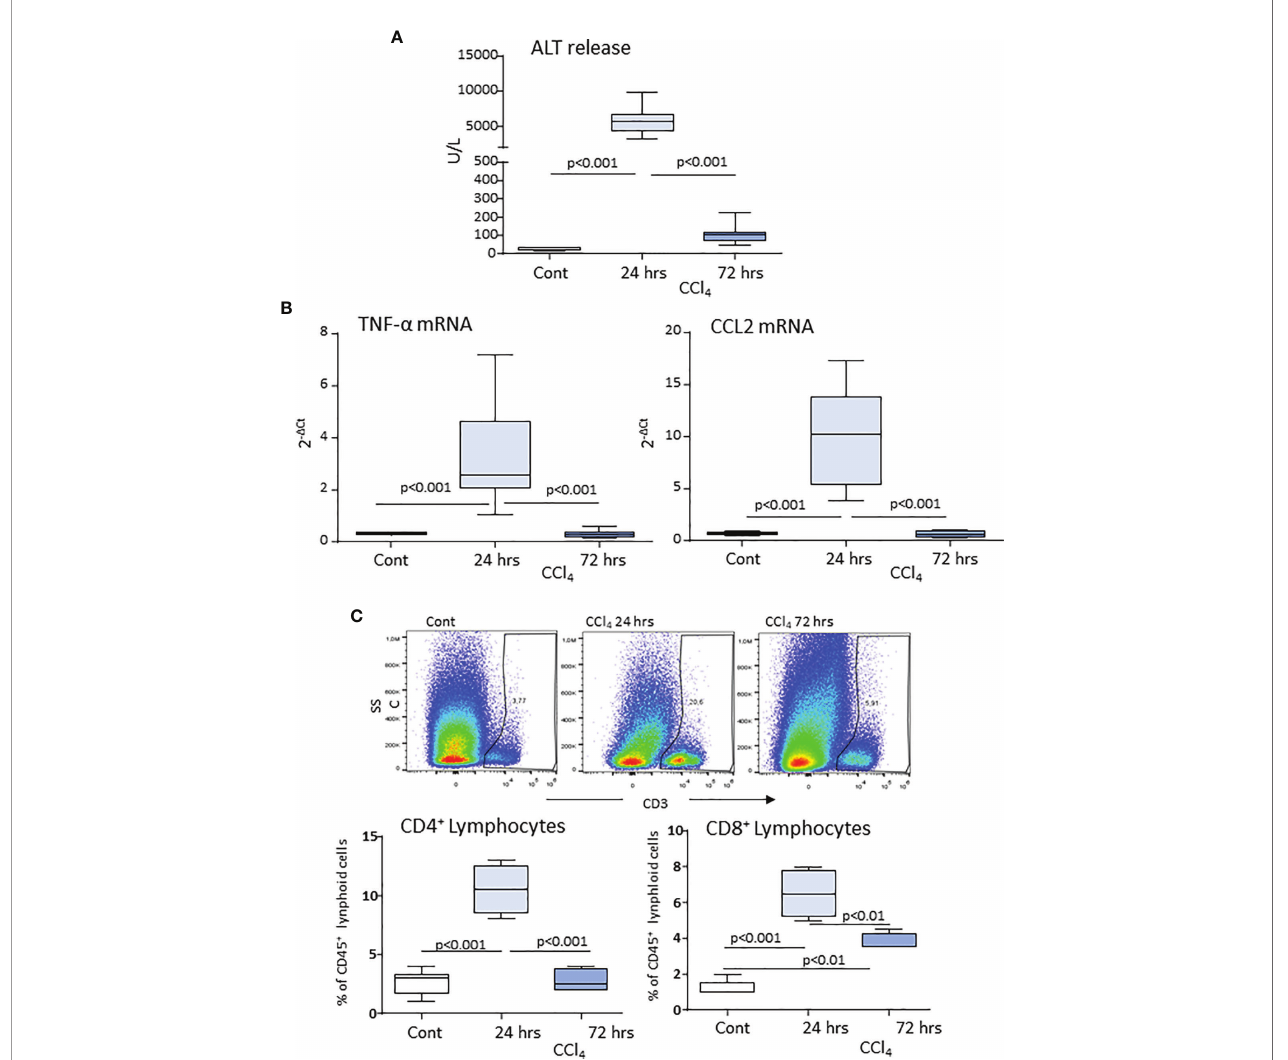
FIGURE 1 | Hepatic lobular in fl ammation following acute liver injury promotes the liver recruitment of lymphocytes. Parenchymal damage, lobular in fl ammation and lymphocyte distribution in response to acute liver injury were analyzed in wild-type mice 24 and 72 hours after receiving an acute dose of CCl 4 . Circulating levels of alanine aminotransferase (ALT) (A) . Real-Time PCR analysis of the hepatic expression of the macrophage in fl ammatory markers TNF- a and CCL2 (B) . Flow cytometry analysis of the liver distribution of CD45 + /CD3 + /CD4 + helper and CD45 + /CD3 + /CD8 + cytotoxic T cells, (C) . The values are expressed as mean ± SD of 5-6